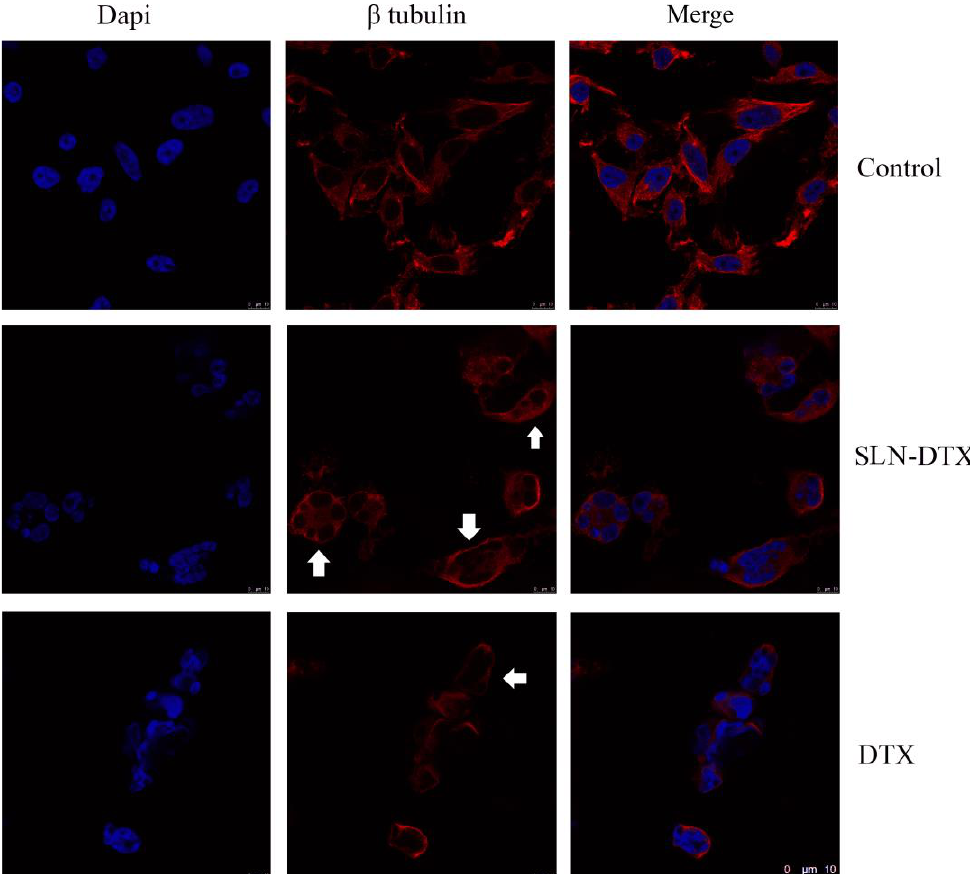
Figure 5. Beta-tubulin immunostaining on MDA-MB-231 after 72 h of treatment. DAPI stained the nucleus in blue, in red is the immunostaining of beta-tubulin and the overlap of the two. The arrows indicate the structure of beta-tubulin, delimiting the segmentations of the nucleus. Scale bar 10 μm.